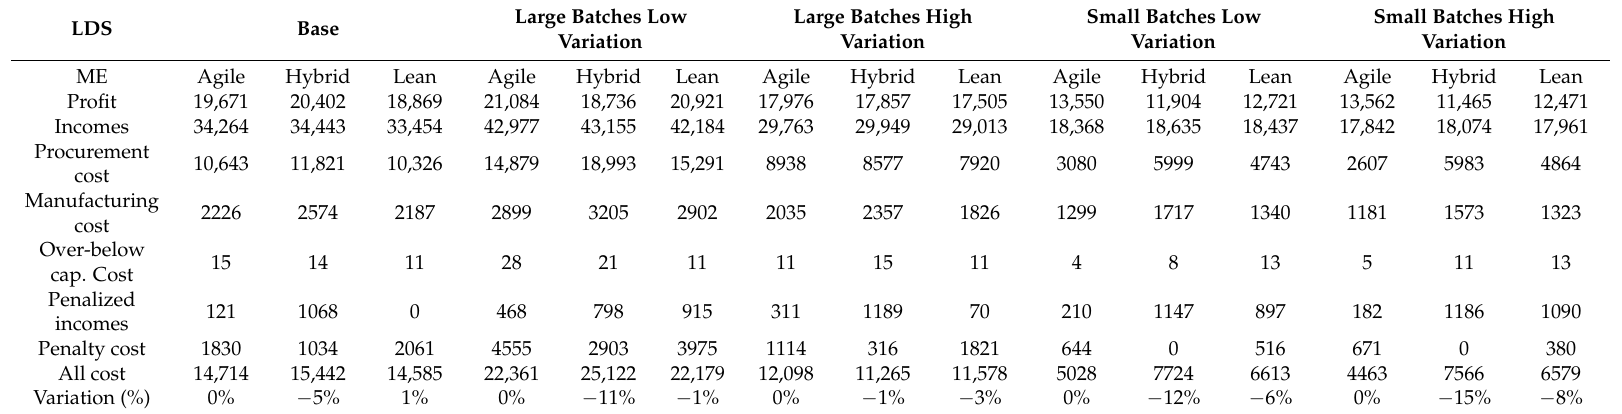
Table A8. Summary of economics by lumber demand scenario (LDS) and manufacturing environment (ME) (in millions of CAD).